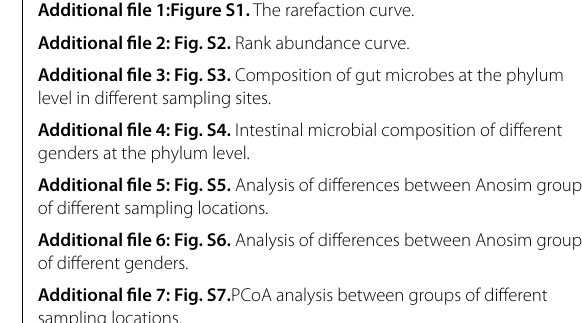
Additional file 5: Fig. S5. Analysis of differences between Anosim groups of different sampling locations. Additional file 6: Fig. S6. Analysis of differences between Anosim groups of different genders. Additional file 7: Fig. S7. PCoA analysis between groups of different sampling locations. Additional file 8: Fig. S8. PCoA analysis between groups of different genders. Additional file 9: Fig. S9. PCA analysis between groups of different sampling locations Additional file 10: Fig. S10. PCA analysis between groups of different genders. Additional file 11: Fig. S11. NMDS analysis between groups of different sampling